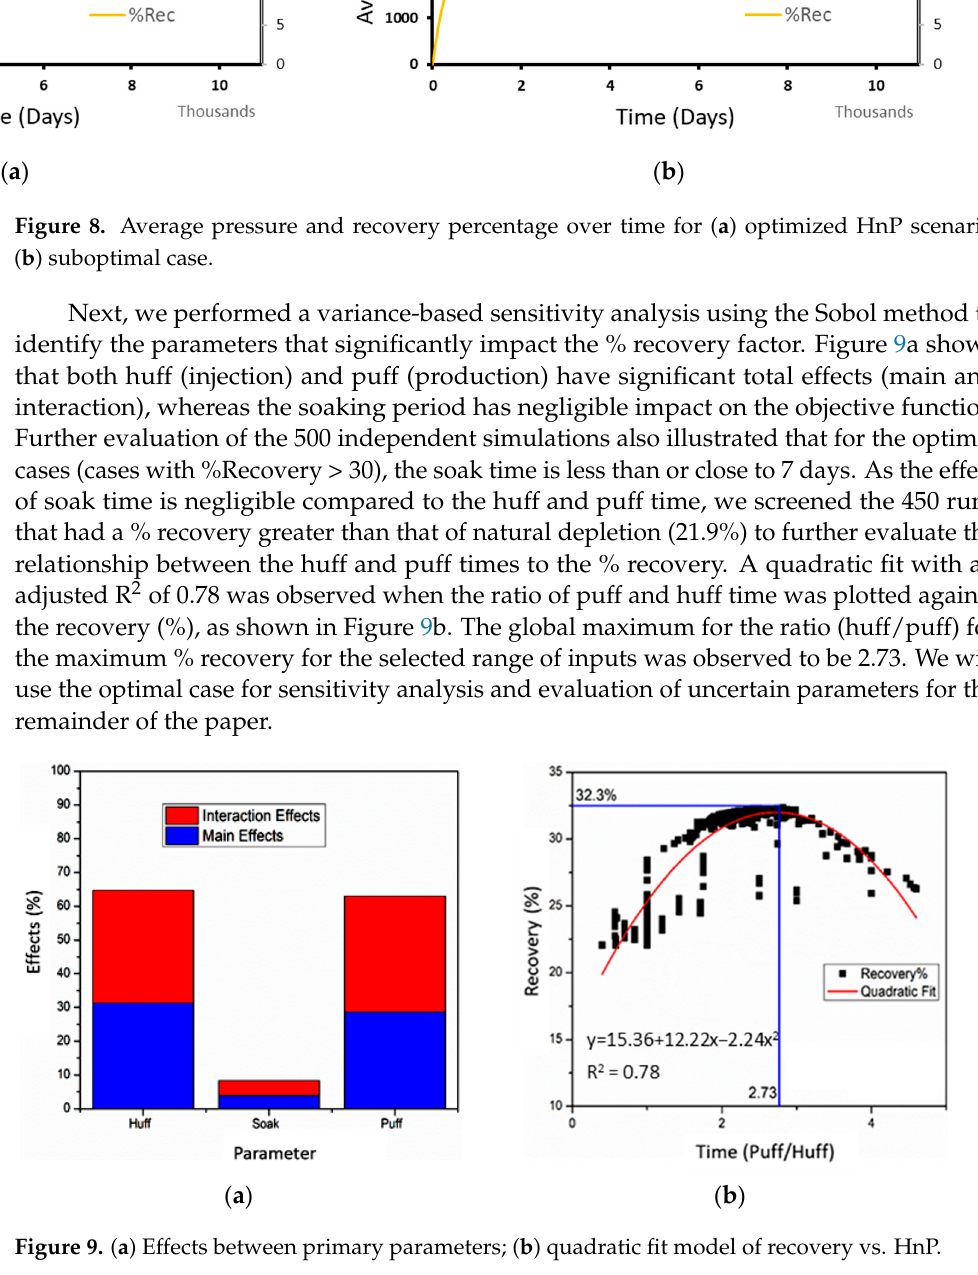
Figure 7. Recovery percentage over time for all simulations.